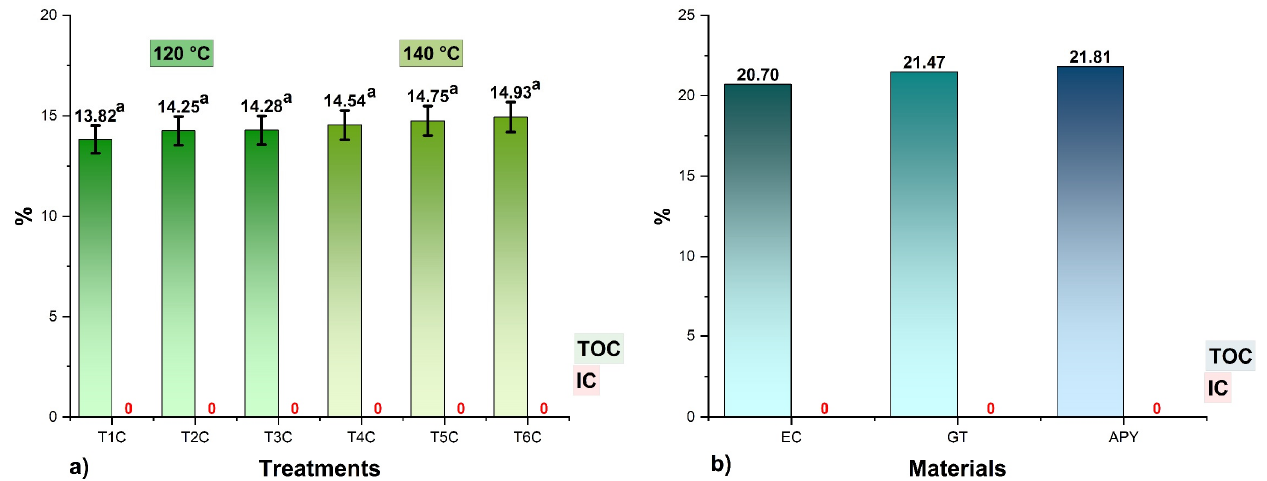
Figure 4. Total organic carbon (TOC) and total inorganic carbon (IC) content in, ( a ) the encapsulates at 120 ◦ C (T1C, T2C, and T3C) and 140 ◦ C (T4C, T5C, and T6C); ( b ) EC, spray-dried C. porcellus erythrocytes; GT, spray-dried tare gum; APY, starch of native potato variety yanapalta.